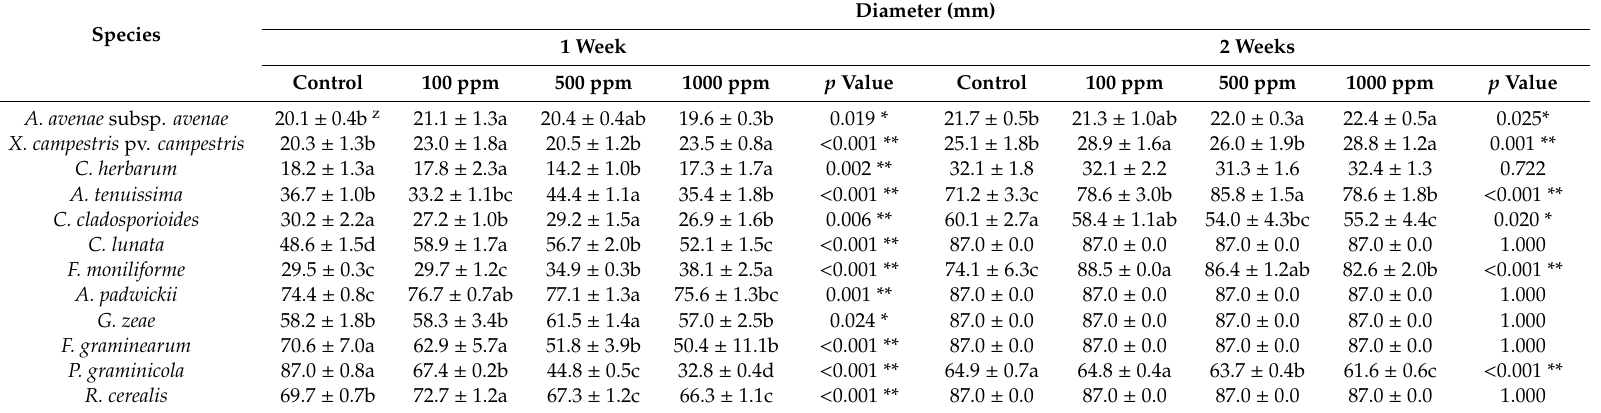
Table 3. Diameter of radial growth of various pathogen species against chrysoeriol